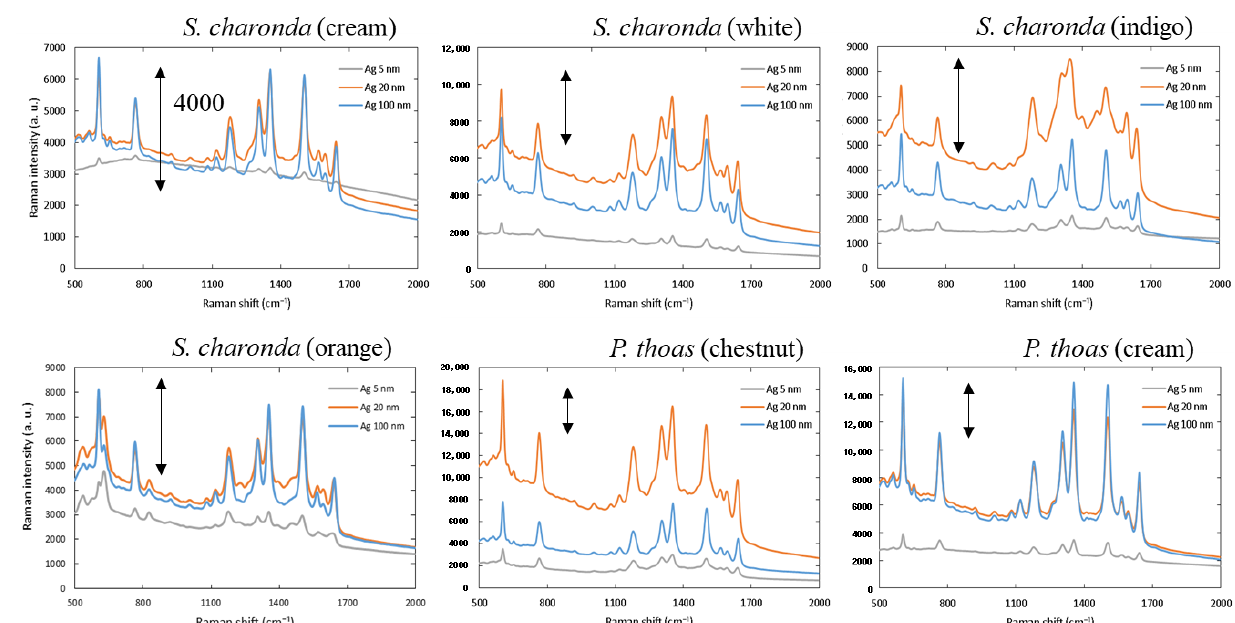
Figure A2. SERS spectra of 1 mM R6G from cream, white, indigo, and orange scales of S. charonda , and chestnut and cream scales from P. thoas . For each type of scales, spectra obtained from scales with 5, 20 and 100 nm silver deposition are shown. Arrow: Raman intensity (a.u.) of 4000.